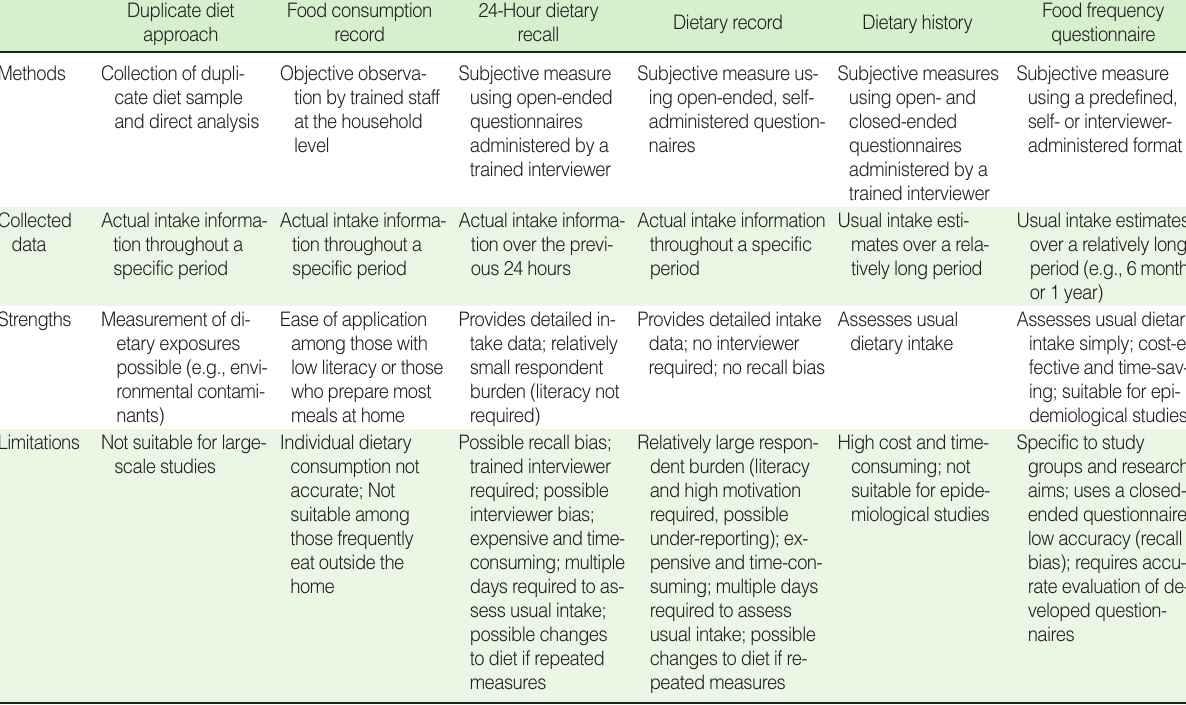
Table 1. Dietary assessment methods in epidemiological